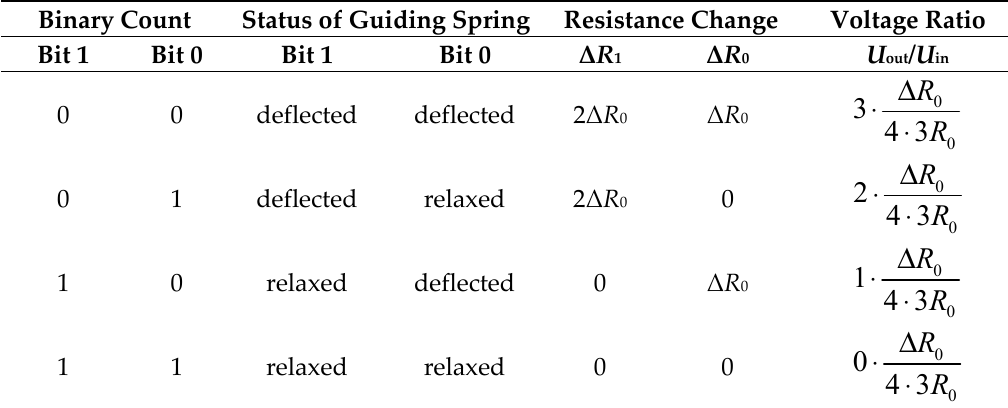
Table 1. Status table according to Equation (2) for a 2-bit digital-to-analog converter arranged in a quarter Wheatstone bridge.